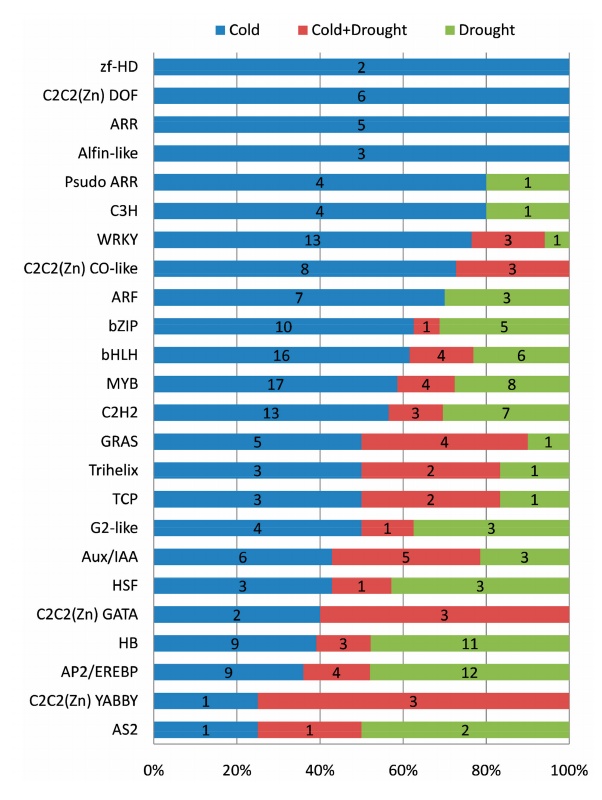
Figure 5. Distribution of transcription factor families differentially expressed in response to cold, drought, or both cold and drought